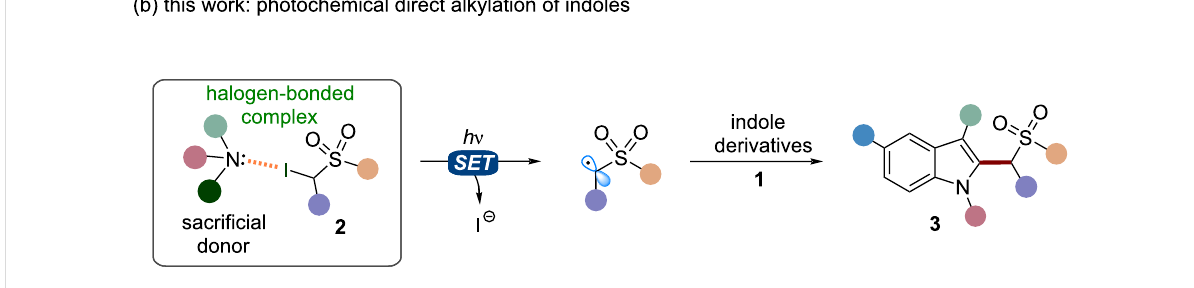
Figure 1: (a) Exploitation of an EDA complex in organic synthesis. (b) This work: use of halogen-bonded complexes to photochemically initiate the C–H alkylation of indoles 1 with iodosulfones 2